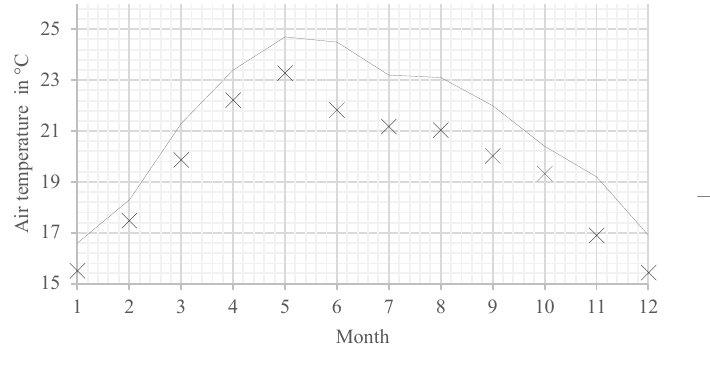
Fig. 1. Average air temperature in sub-humid warm